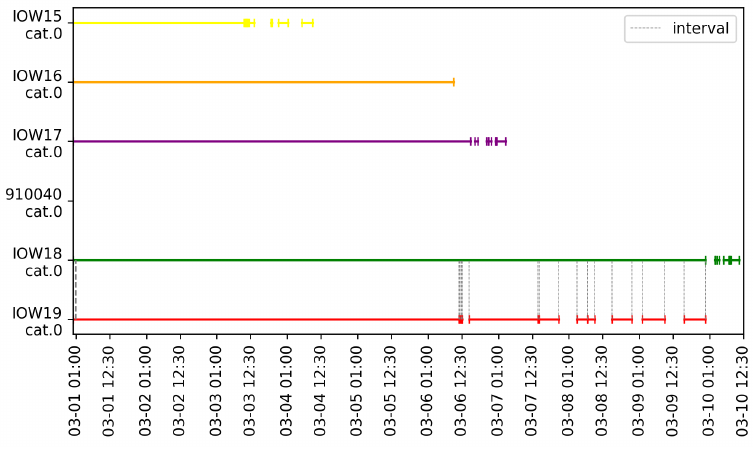
Figure 21. TNCPs for Query 1 and ec = 0.